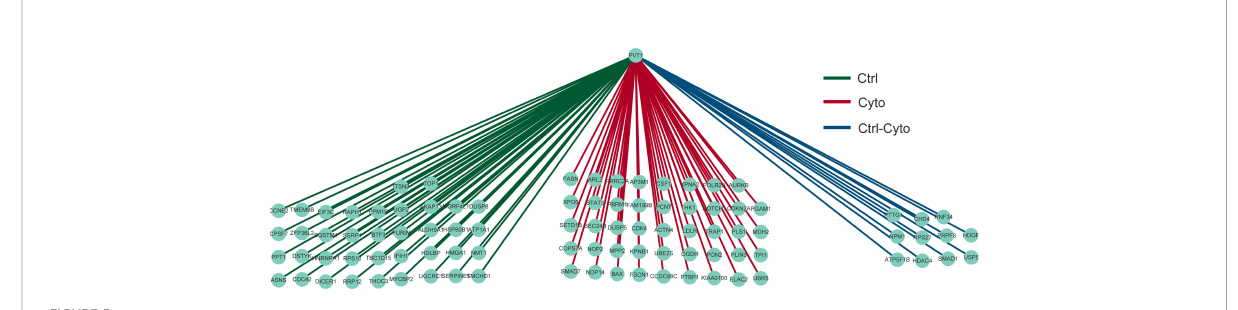
FIGURE 5 Differential regulation of LncRNA PVT1 with or without cytokines stimulation.